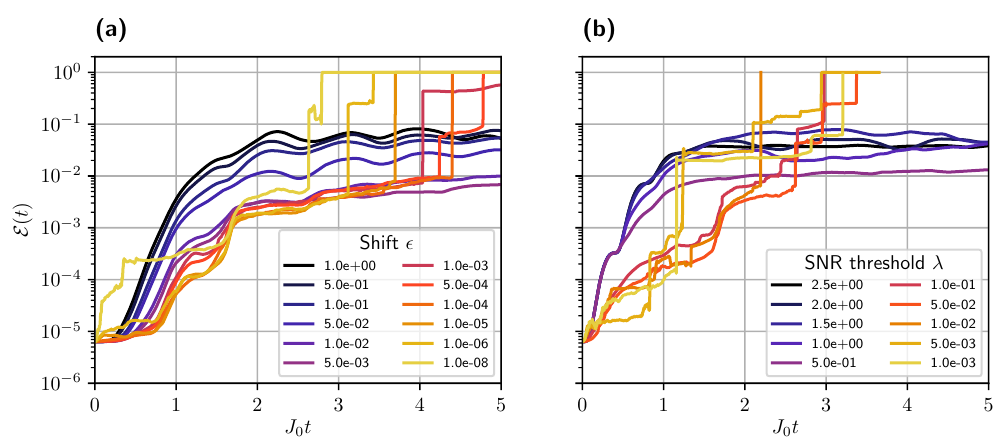
Figure 13: Infidelity of the time-evolved variational state compared to the exact tra- jectory for (a) the diagonal shift regularization with varying strength ε and (b) the signal-to-noise (SNR) ratio based regularization of Ref. [ 44 ] with varying threshold λ . The trajectories have been computed using t-VMC with EMC at a moderate ex- SNR = 0.10 in the 8 × 2 ladder geometry using the symmetrized citation strength of A p RBM ansatz with a hidden unit density of α =